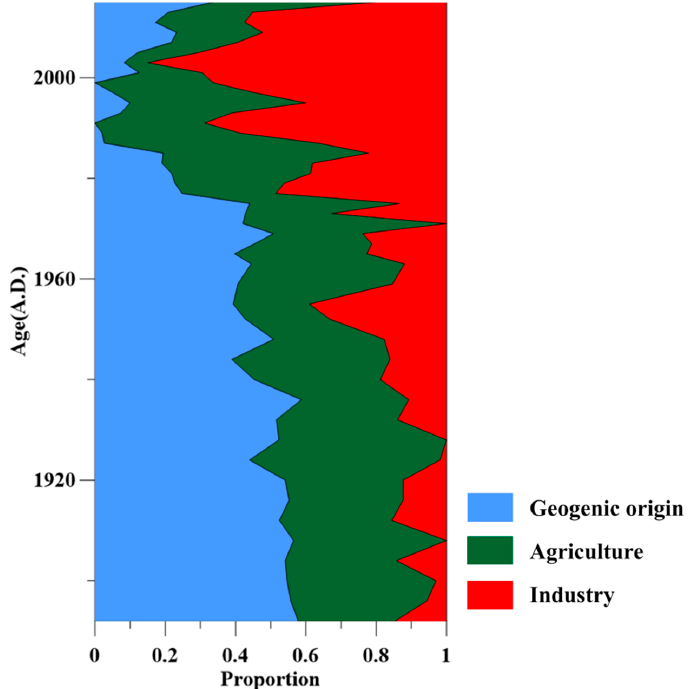
Figure 5. Variation in the composition of pollution sources of sediment heavy metals with time based on the positive matrix factorization (PMF) model.